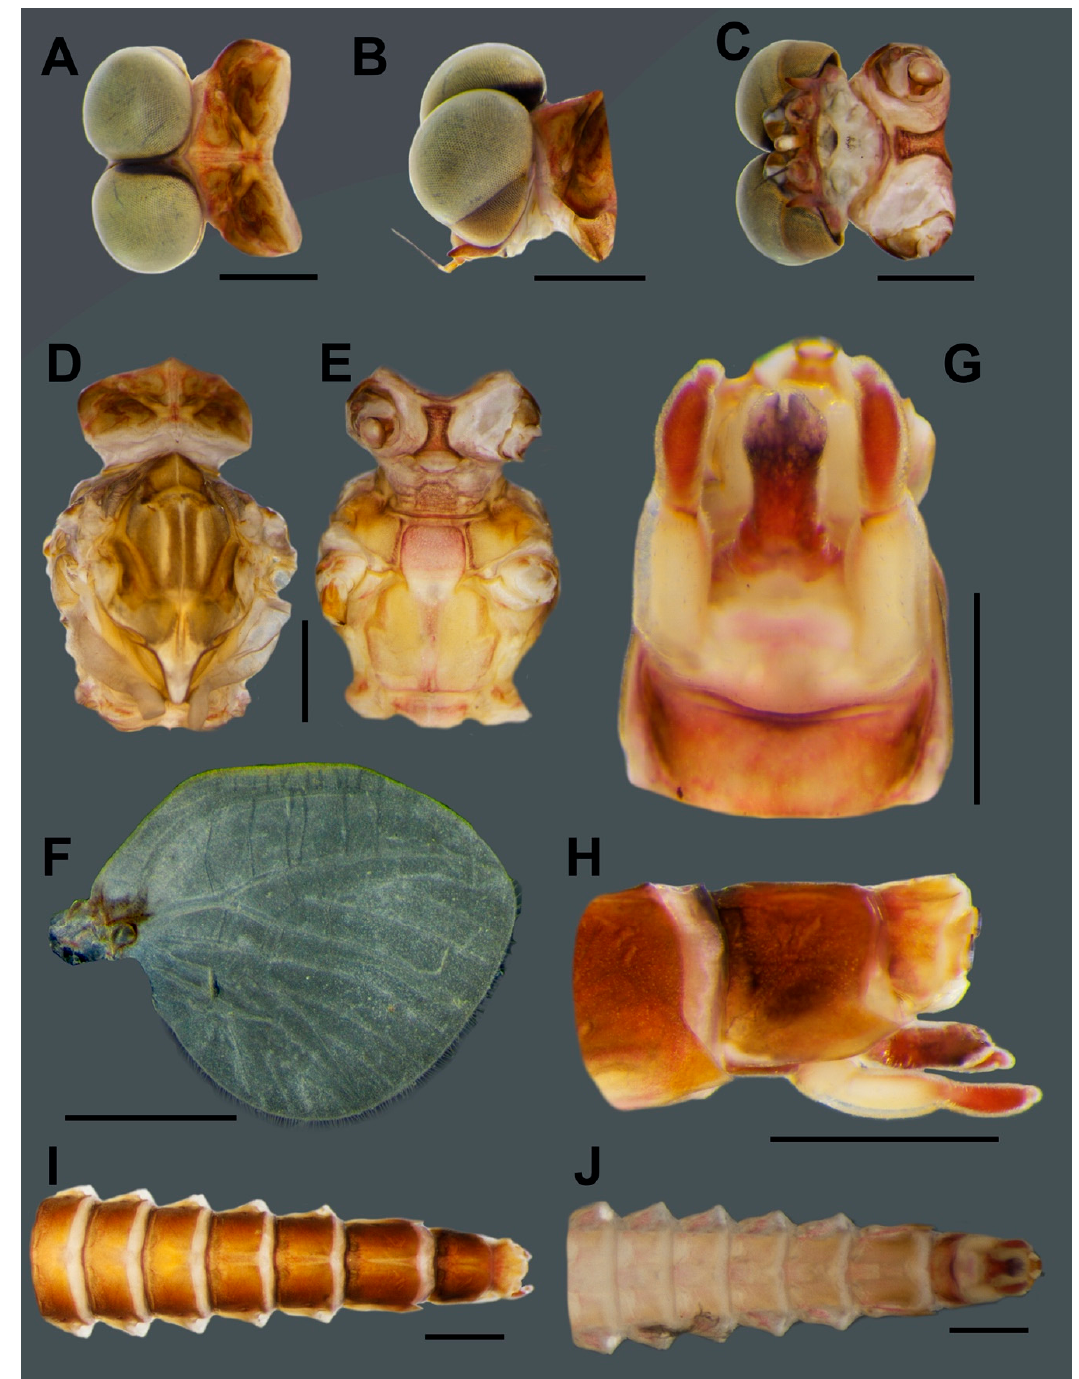
Figure 4. Male subimago of Vietnamella nanensis sp. n. Dorsal ( A ), lateral ( B ) and ventral ( C ) views of head; dorsal ( D ) and ventral ( E ) views of thorax; ( F ) hindwing; ventral ( G ) and lateral ( H ) views of genitalia; dorsal ( I ) and ventral ( J ) views of abdomen. Scale bars: 1 mm.